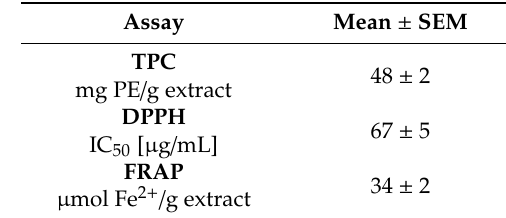
Table 2. Reducing / antiradical activity of Rosmarinus o ffi cinalis L. flowers’ extract.